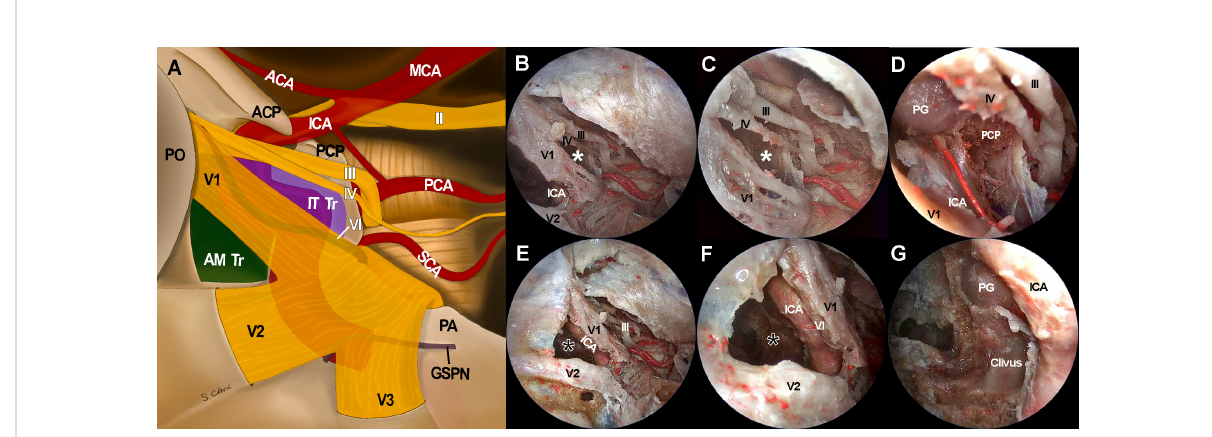
FIGURE 5 Access to intracavernous neurovascular structures through surgical windows under endoscopic transorbital approach (ETOA). (A) Illustration of skull base view under ETOA shows neurovascular structures inside and around cavernous sinus. Lateral orbital wall is removed and superior orbital fi ssure is opened. Sphenoid sinus also opened by drilling the sphenoid bone under the anteromedial triangle (green shadow). Infratrochlear triangle (purple shadow) was demarcated by the ophthalmic branch of a trigeminal nerve (V1) and a trochlear nerve. Dura including tentorium is widely excised. Abducens nerve and greater super fi cial petrosal nerve travel under the trigeminal nerve and V1 which are demonstrated transparently. (B – D) The infratrochlear triangle (white asterisks) allowed the access to the posterior region of cavernous sinus where the dorsal surface of internal carotid artery (ICA) was accessed. Posterior clinoid process was straightly directed by this window under an ETOA view. (E – G) The anteromedial triangle (black asterisks) was the main entrance to the lateral compartment of the cavernous sinus. The ventral surface of ICA horizontal segment was approached through this window. With a minimal retraction of V1 superiorly, abducens nerve was exposed just behind V1. Inferior compartment was also safely accessed through anteromedial triangle. ACA, anterior cerebral artery; AM Tr, anteromedial triangle; ICA, internal cerebral artery; II, optic nerve; III, oculomotor nerve; IT Tr, Inferior trochlear triangle; IV, trochlear nerve; GSPN, greater super fi cial petrosal nerve; MCA, middle cerebral artery; PCA, posterior cerebral artery; PCP, posterior clinoid process; PG, pituitary gland; PO, periorbita; SCA, superior cerebellar artery, V1, ophthalmic branch of trigeminal nerve; V2, maxillary branch of trigeminal nerve; V3, mandibular branch of trigeminal